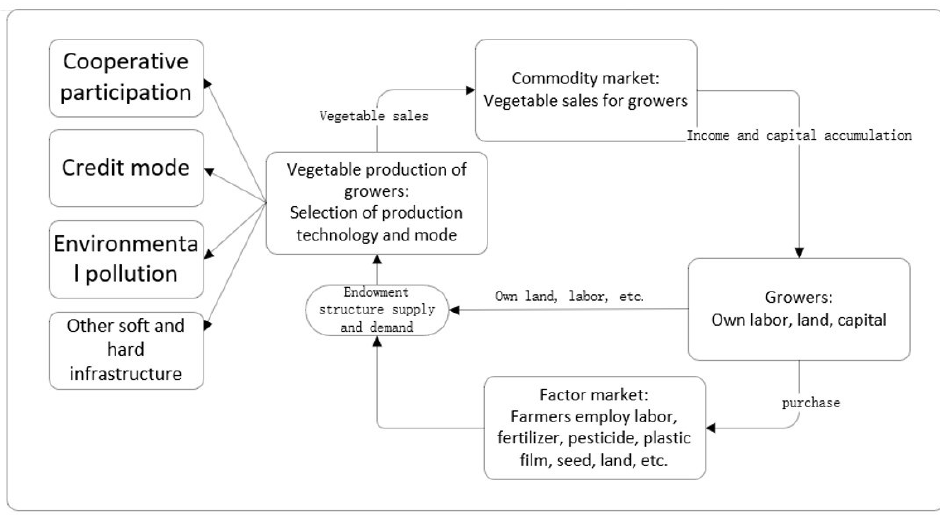
Figure 1. Circulation flow chart of upgrading the vegetable industry.